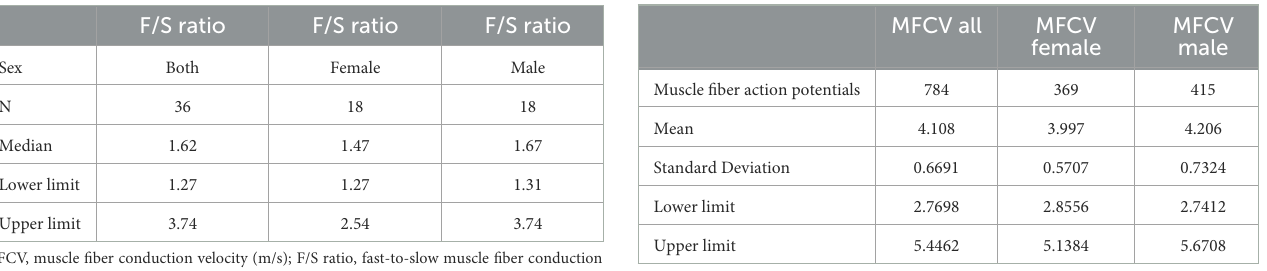
TABLE 2 Median and reference limits for the F/S ratio variable and sex. TABLE 3 Mean and reference limits of MFCV from 784 individual